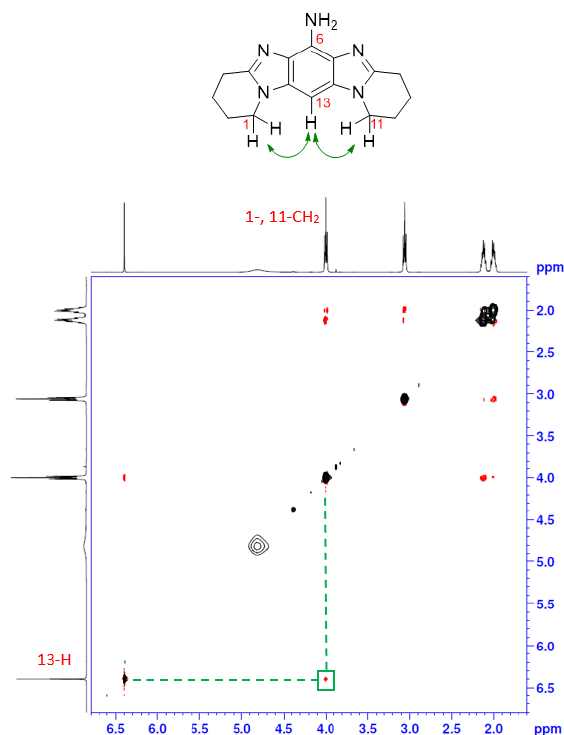
Figure 2. NOESY spectrum of aromatic amine 6 , with highlighted through-space 1 H- 1 H coupling.